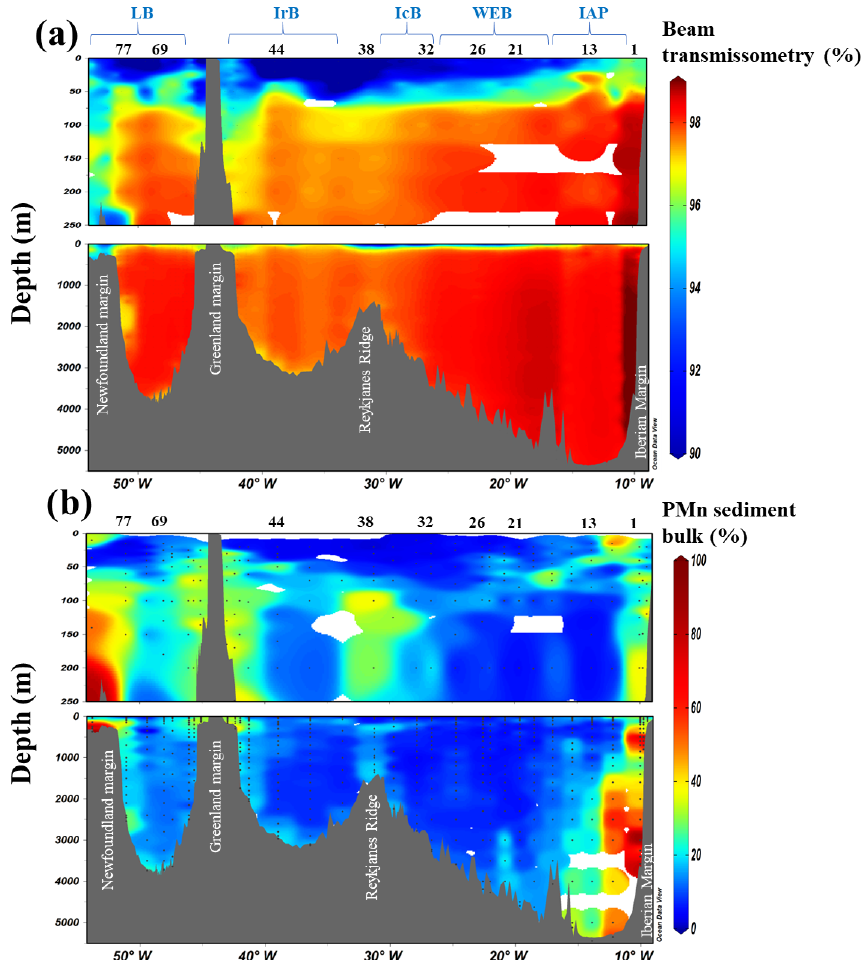
Figure 4. Section of derived contributions of sedimentary inputs along the GA01 section with (a) beam transmissometry (%) and (b) man- ganese bulk sediment proxy (%) based on Eq. (3). Station IDs and biogeochemical region are indicated above section (a) in black numbers and blue letters, respectively. This figure was generated using Ocean Data View (Schlitzer, R., Ocean Data View, http://odv.awi.de/,